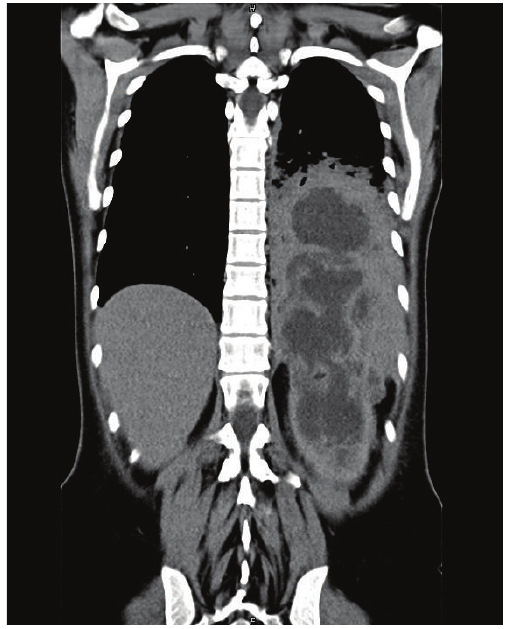
Figure 1: CT-scan revealing a large perinephric abscess with subphrenic extension and perforation of the diaphragm, causing a gigantic empyema which occupied the lower two thirds of the left hemithorax, totaling a 30 cm large abscess on its largest axis.